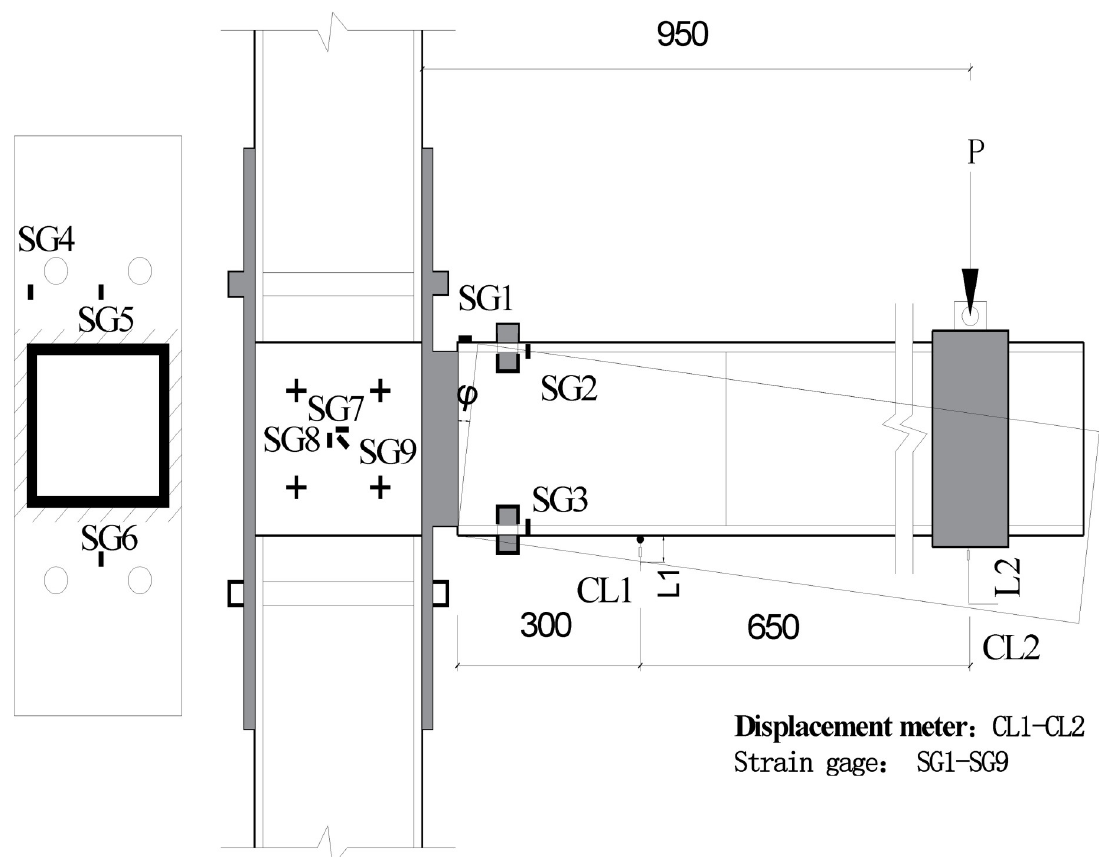
Fig 4. Diagram of strain gage and displacement